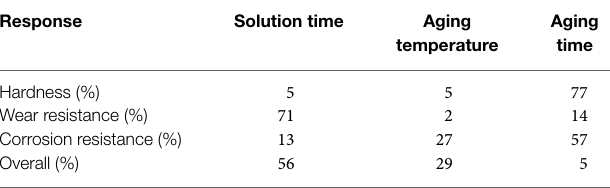
TABLE 3 | Influence of heat treatment parameters on hardness, wear, and corrosion resistance